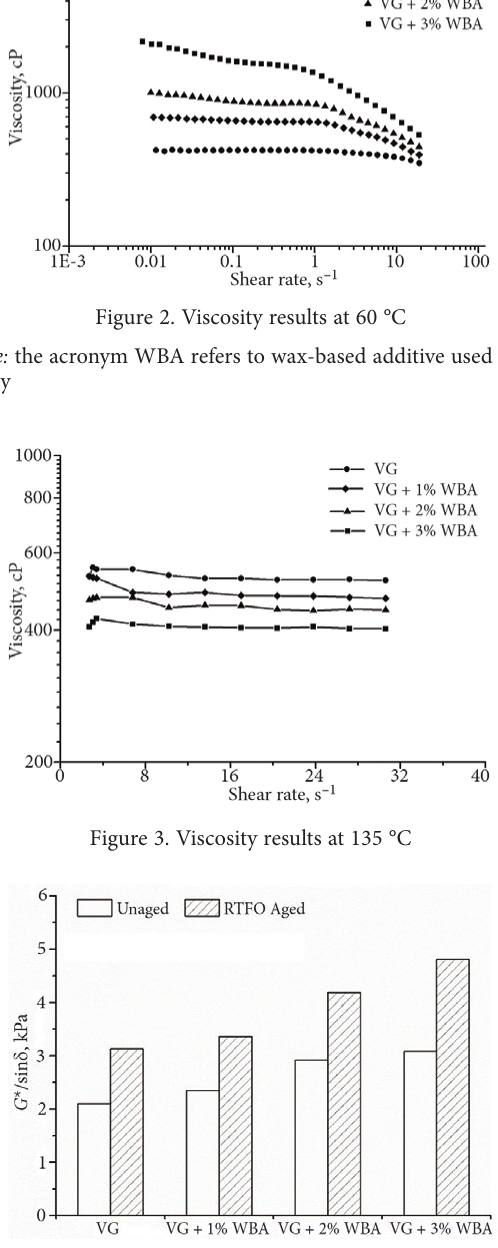
Figure 4. G* /sinδ results at 64